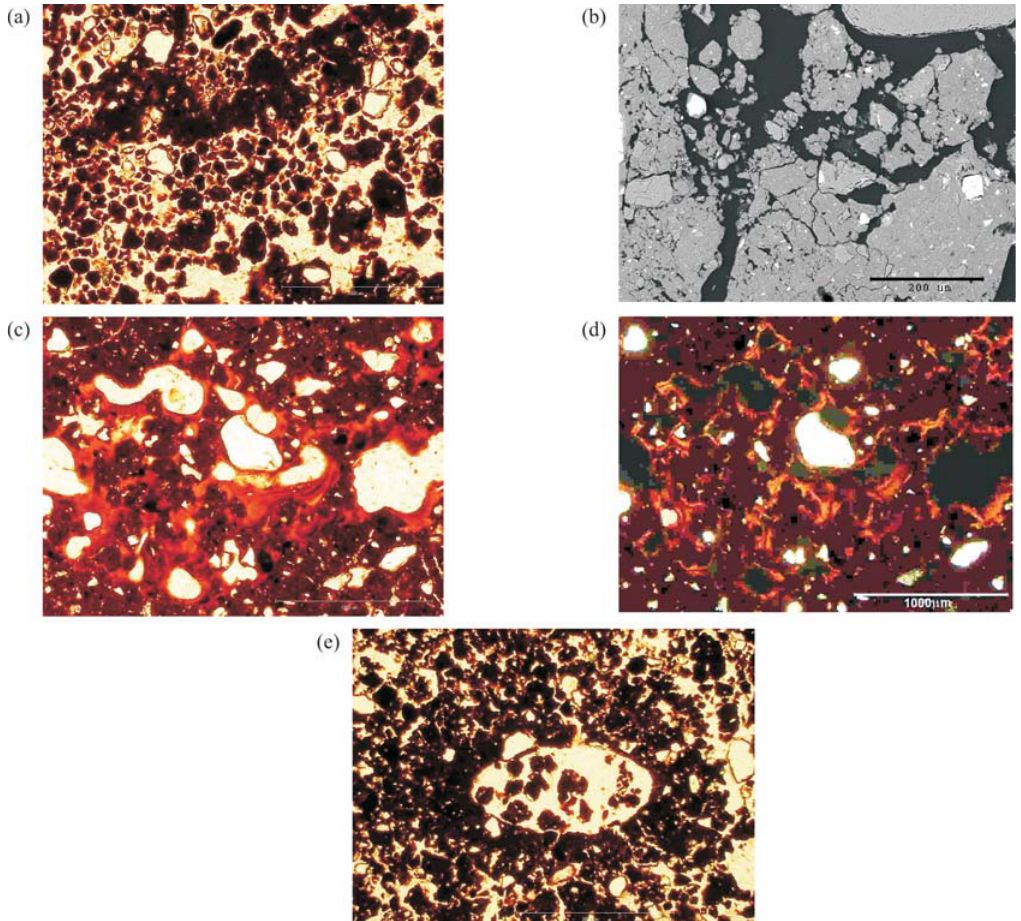
Figure 3. Microphotographs of the micro-fissuration and illuviation processes. (a) Dismantling of the porphyric C/F related distribution by fissuration processes forming micro-granular aggregates (Horizon Bn2, profile 1), (b) backscattered electron image detailing the micro-fissuration process (voids in black), (c) clay coatings filling the packing voids and polyconcave vughs cementing the micro-granular aggregates (PPL) (Horizon Bn1, profile 2), (d) same image in XPL, (e) biological vugh with loose and continuous infillings and dense walls due to